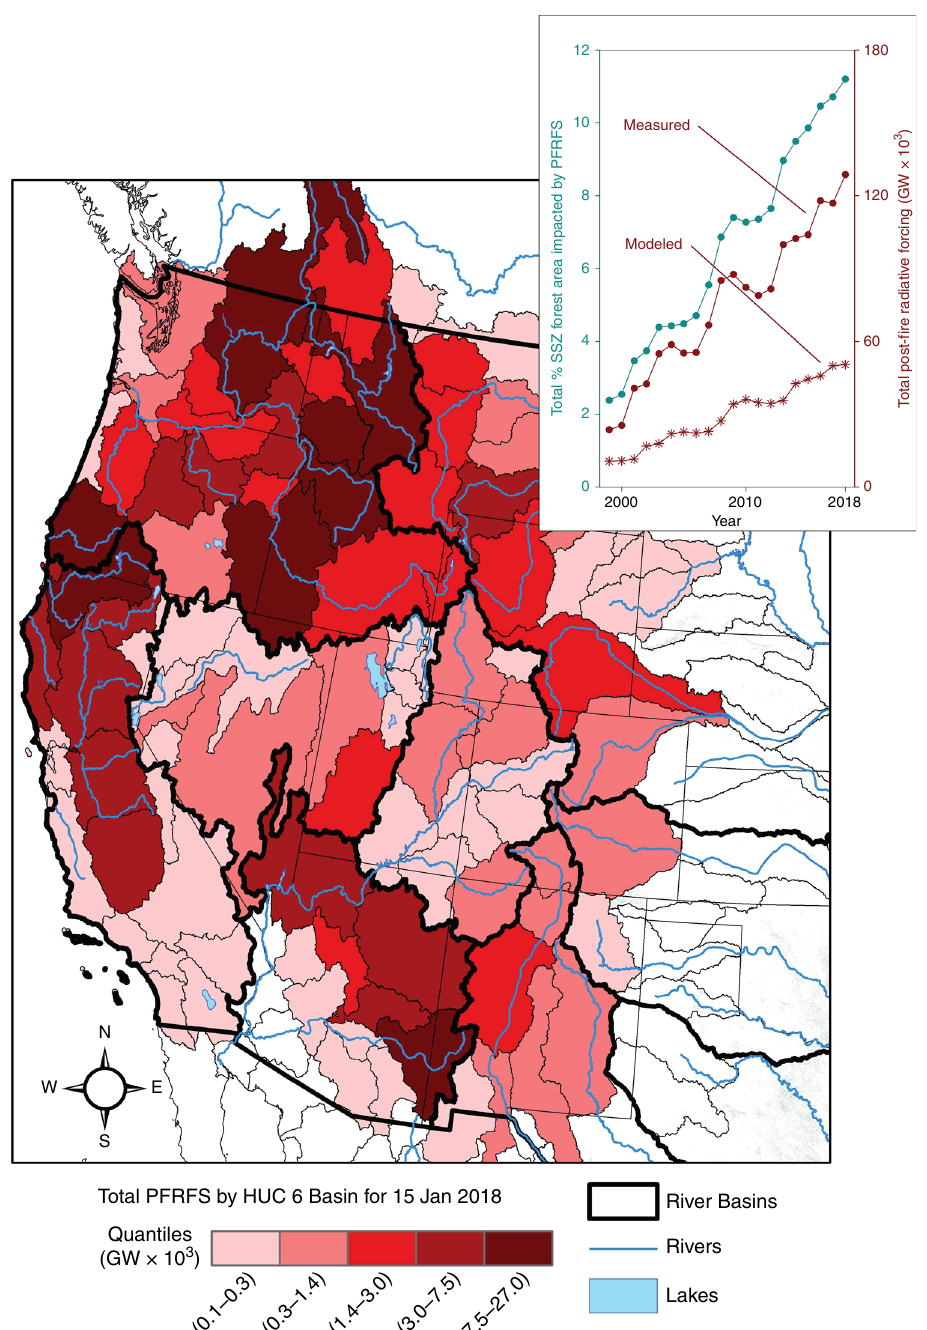
Fig. 4 Total daily post- fi re radiative forcing on snow (PFRFS) in the western U.S. for 15 January 2018 based on measured albedo values from 2017 chronosequence of burned forests, and change from 1999 through 2018 based on SNICAR-modeled (red dots) and measured (red stars) albedo values (inset). A 372% (modeled) to 443% (measured) increase in post- fi re radiative forcing on snow occurred since 1999, and currently over 11% of all forests in the seasonal snow zone are experiencing enhanced radiative forcing due to forest fi re occurrence within the last 15